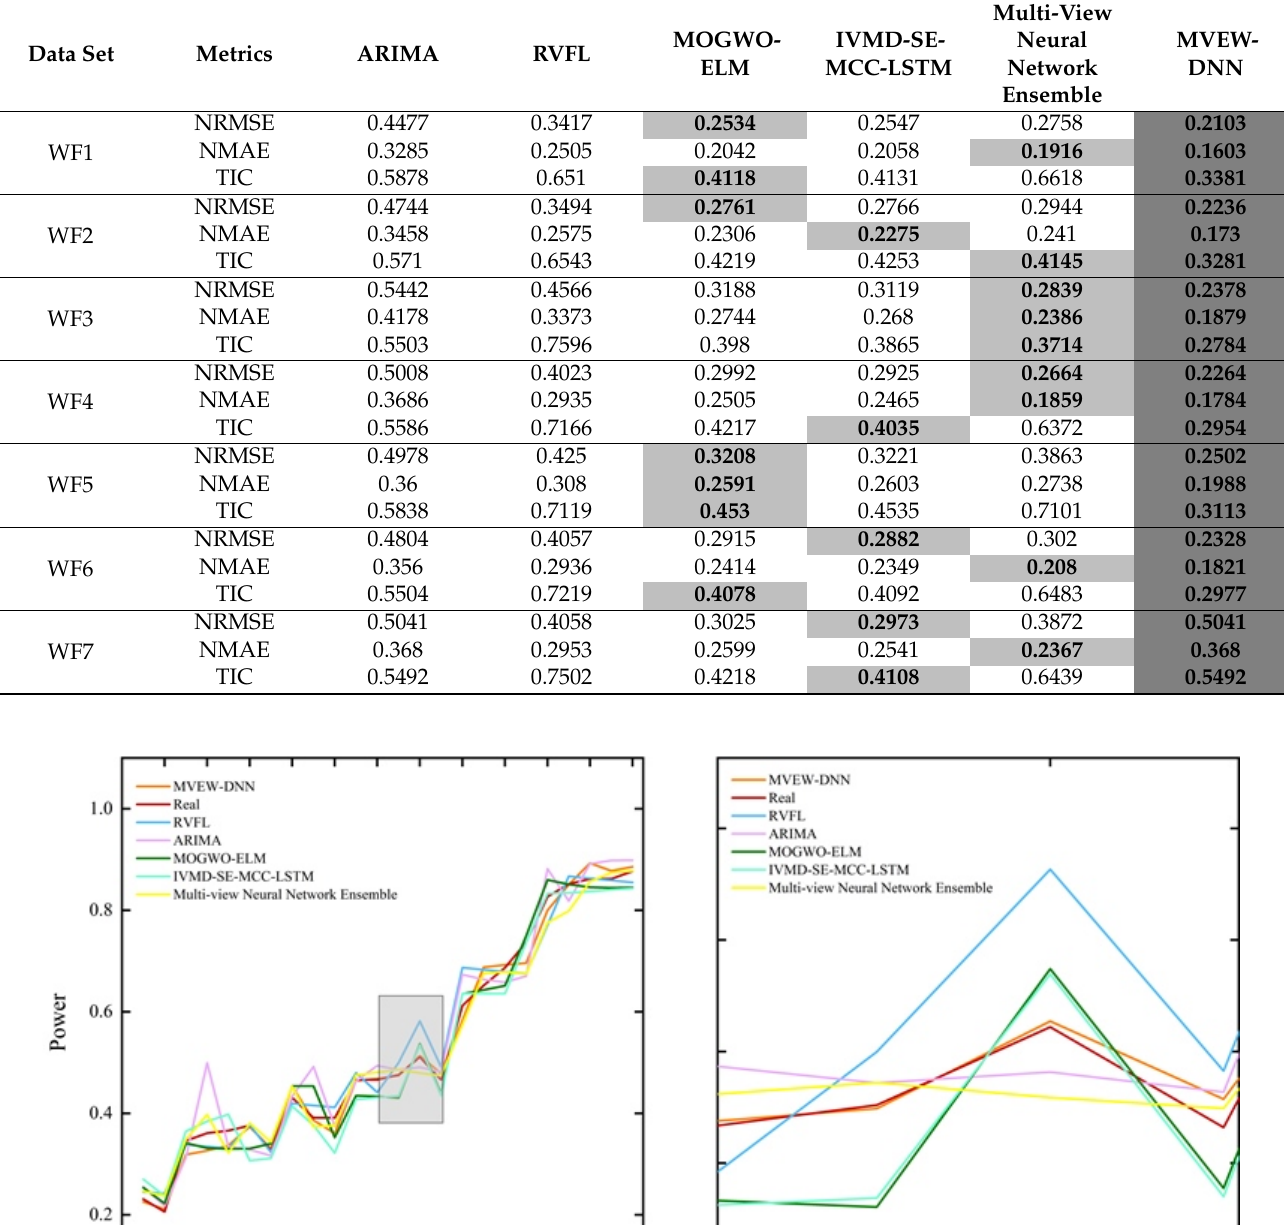
Table 1. The NRMSE, NMAE, and TIC assessment results of the 6 models.